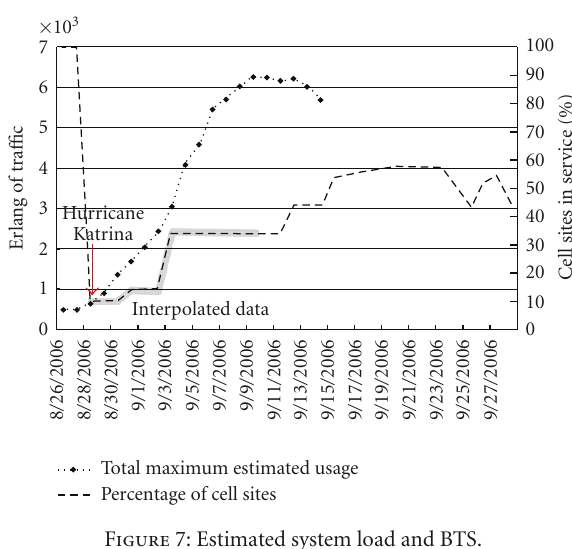
Figure 7: Estimated system load and